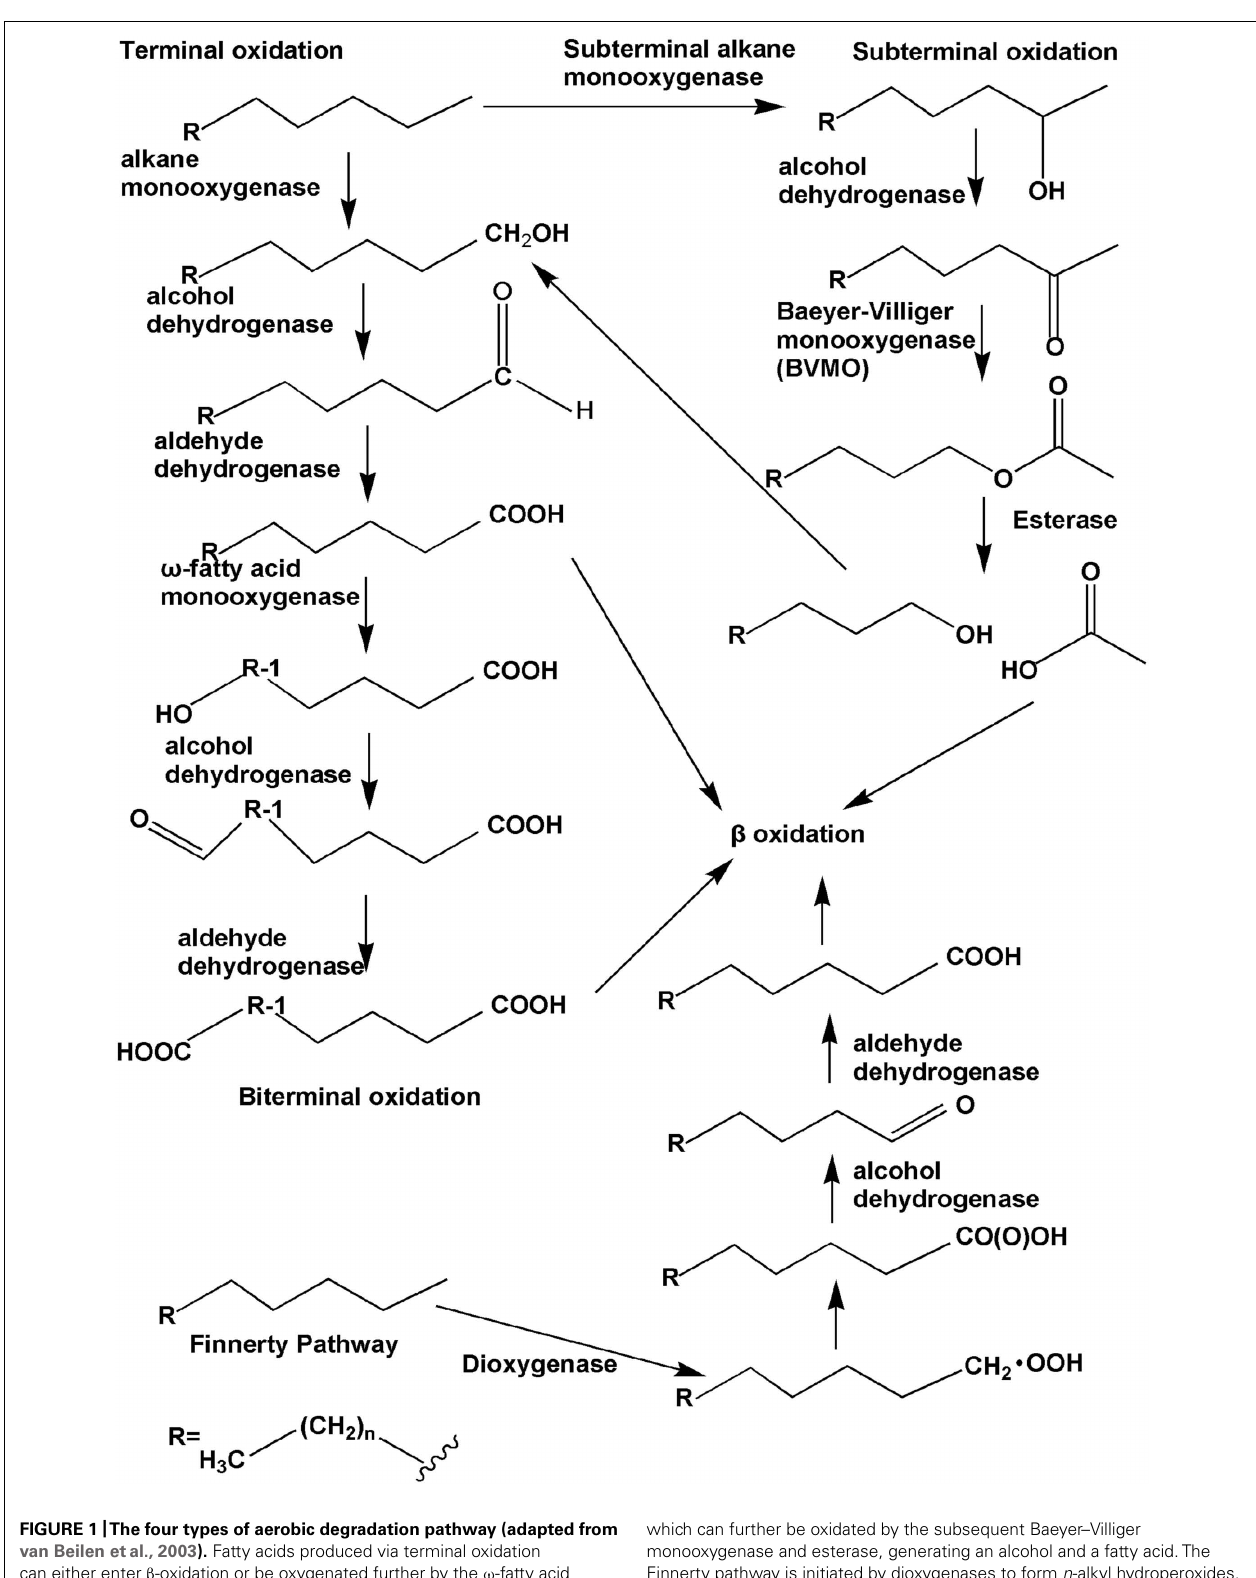
which can further be oxidated by the subsequent Baeyer–Villiger monooxygenase and esterase, generating an alcohol and a fatty acid.The Finnerty pathway is initiated by dioxygenases to form n -alkyl hydroperoxides, which are then in turn oxidized to peroxy acids, alkyl aldehydes, and fatty